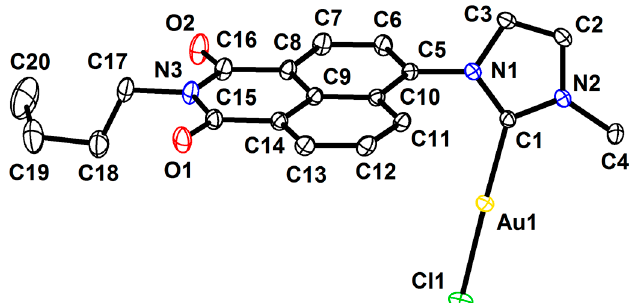
Figure 2. View of the molecular structure of the gold carbene complex [( L 1 )–Au–Cl] ( 1c ). Selected bond distances (Å) and angle ( ◦ ). Au(1)–C(1) = 1.986(2), Au(1)–Cl(1) = 2.287(1), N(1)–C(1) = 1.353(3), N(1)–C(3) = 1.388(3), N(1)–C(5) = 1.427(3), N(2)–C(1) = 1.338(3), N(2)–C(2) = 1.381(3), N(2)–C(4) =